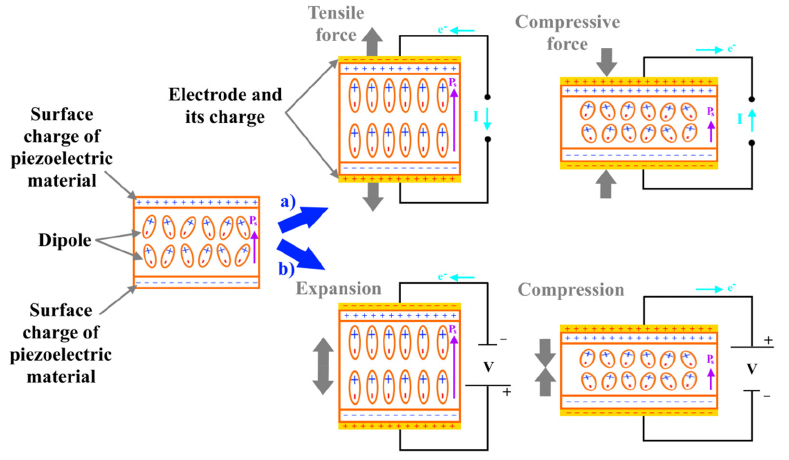
Figure 8. Schematic representation of piezoelectric effects depending on stress and voltage: ( a ) ap ‐ plying a stress, ( b ) applying a voltage. ( a ) applying a stress, ( b ) applying a voltage. Poly(vinylidene fluoride) (PVDF) and its copolymers and polypropylene (PP) are the Poly(vinylidene fluoride) (PVDF) and its copolymers and polypropylene (PP)